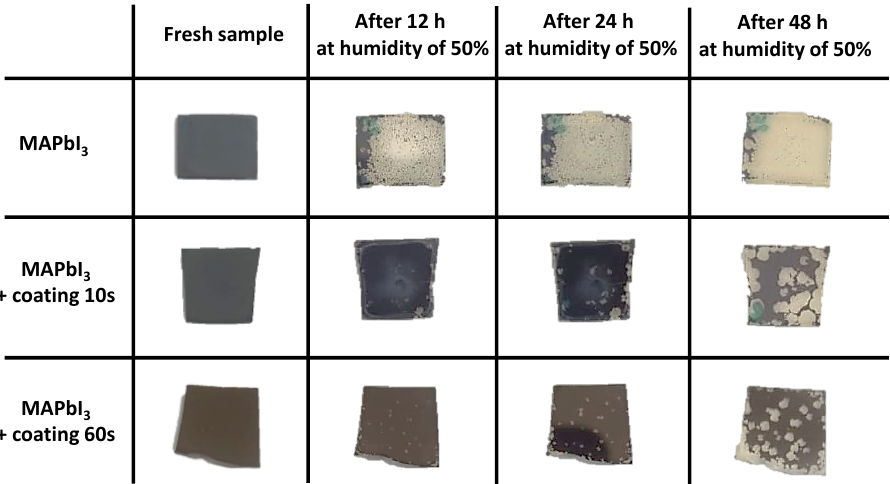
Figure 8. Photographs of pristine MAPbI 3 film and of samples obtained after the plasma deposition (10 and 60 s) of the fluorocarbon coating on the perovskite at different times of storage (0, 12, 24 and 48 h) in a sealed glass chamber at humidity of 50% and temperature of 25 °C.